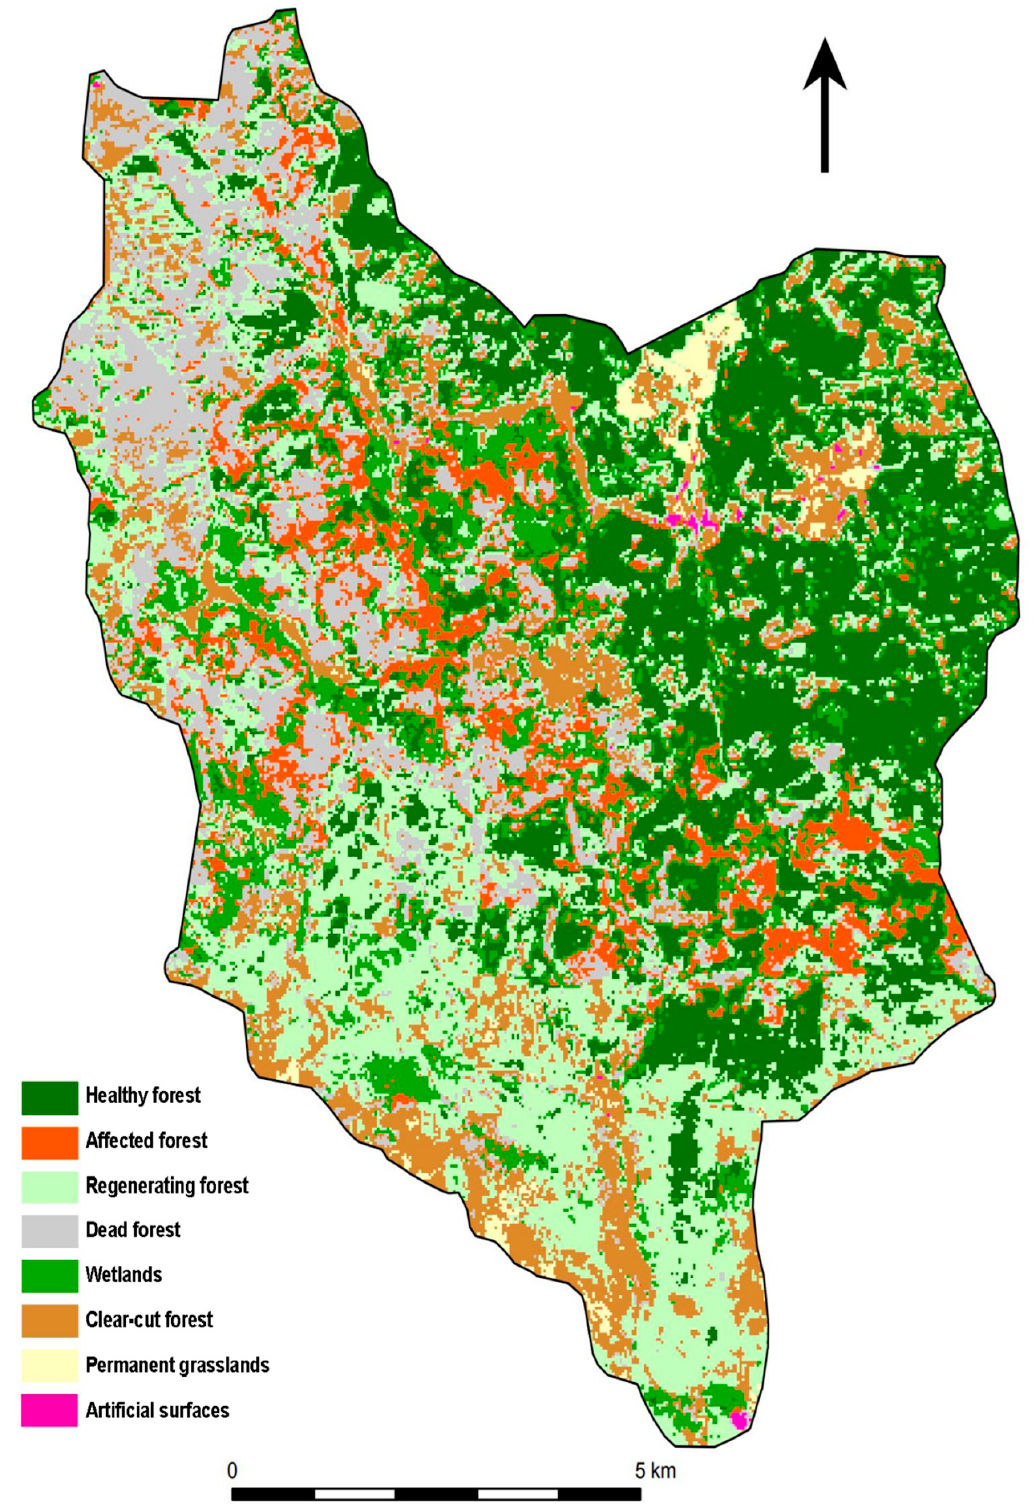
Figure A12. Classification SVM, Landsat 8, 2016, NP Sumava.